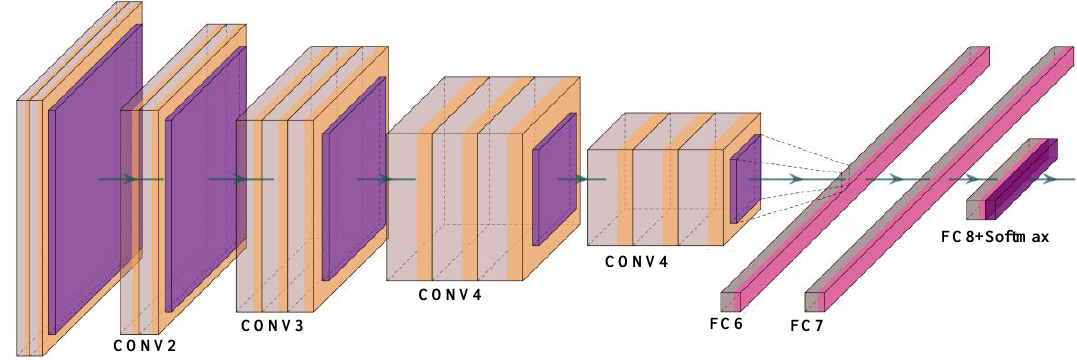
Figure 4. VGG16 and VGG19 architectures; CONV: convolution layer and FC: fully connected network.